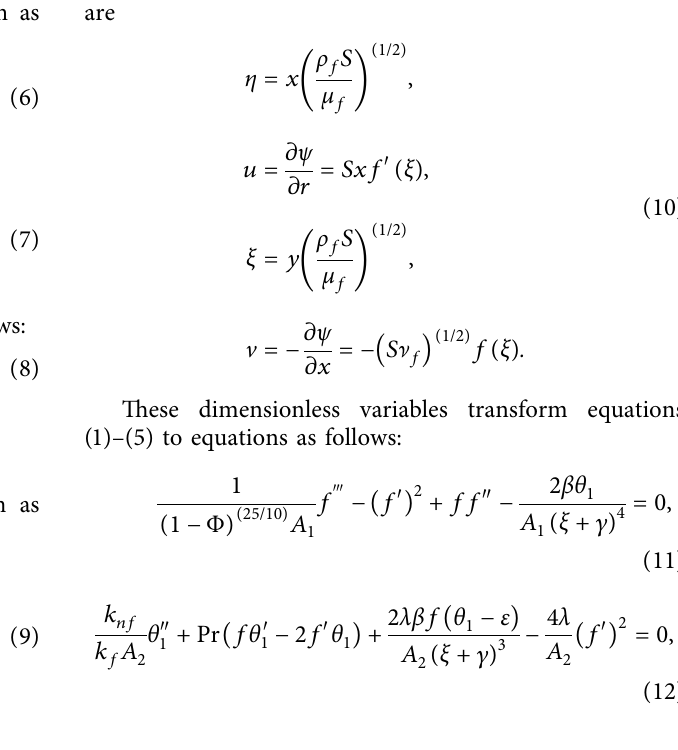
H and magnesium alloy MgZn 8 18